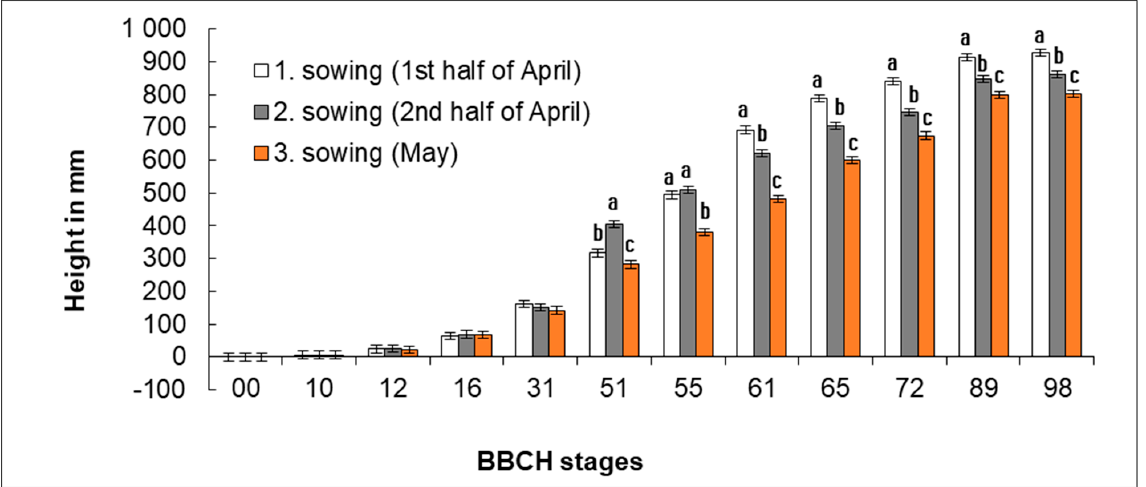
Figure 4. Effect of sowing date of the height of plants reached in the respective developmental stages. Average values ( n = 90) of individual variants are shown for the specific developmental stages (BBCH) in three years of study ± SD. Different letter indices are added only to variants in which significant differences were found ( p < 0.05). If there are no letter indices, no significant dif- ferences between the individual variants were found.